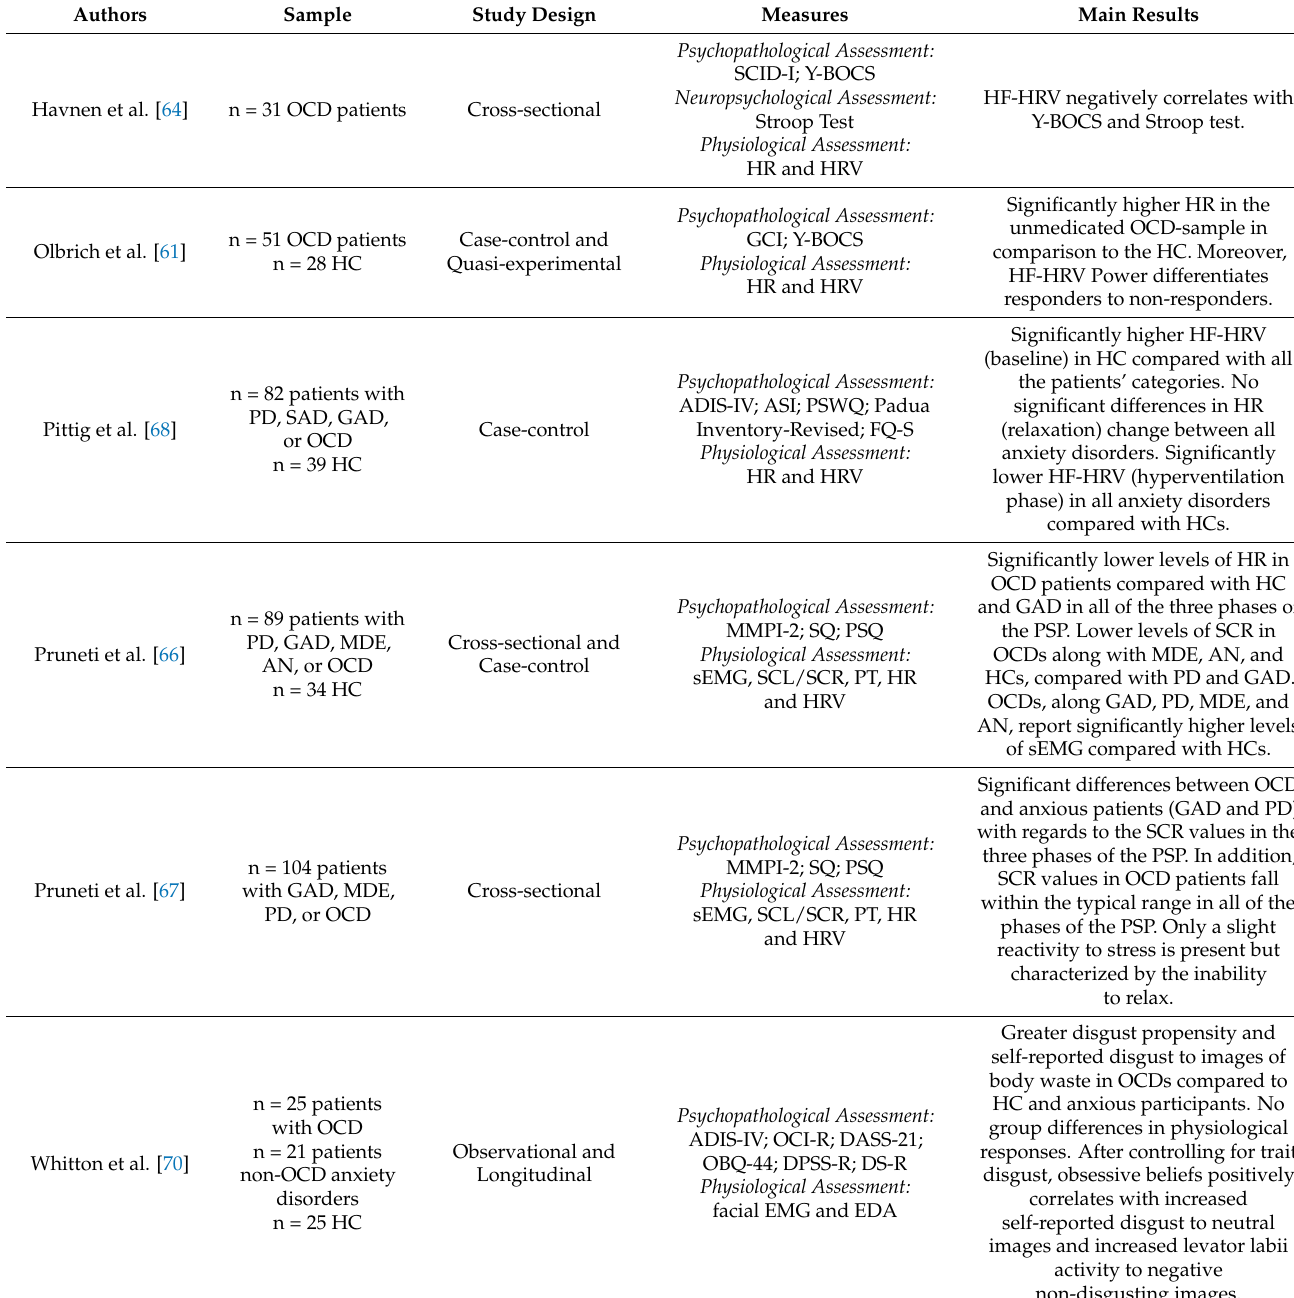
Table 1. Characteristics of Included